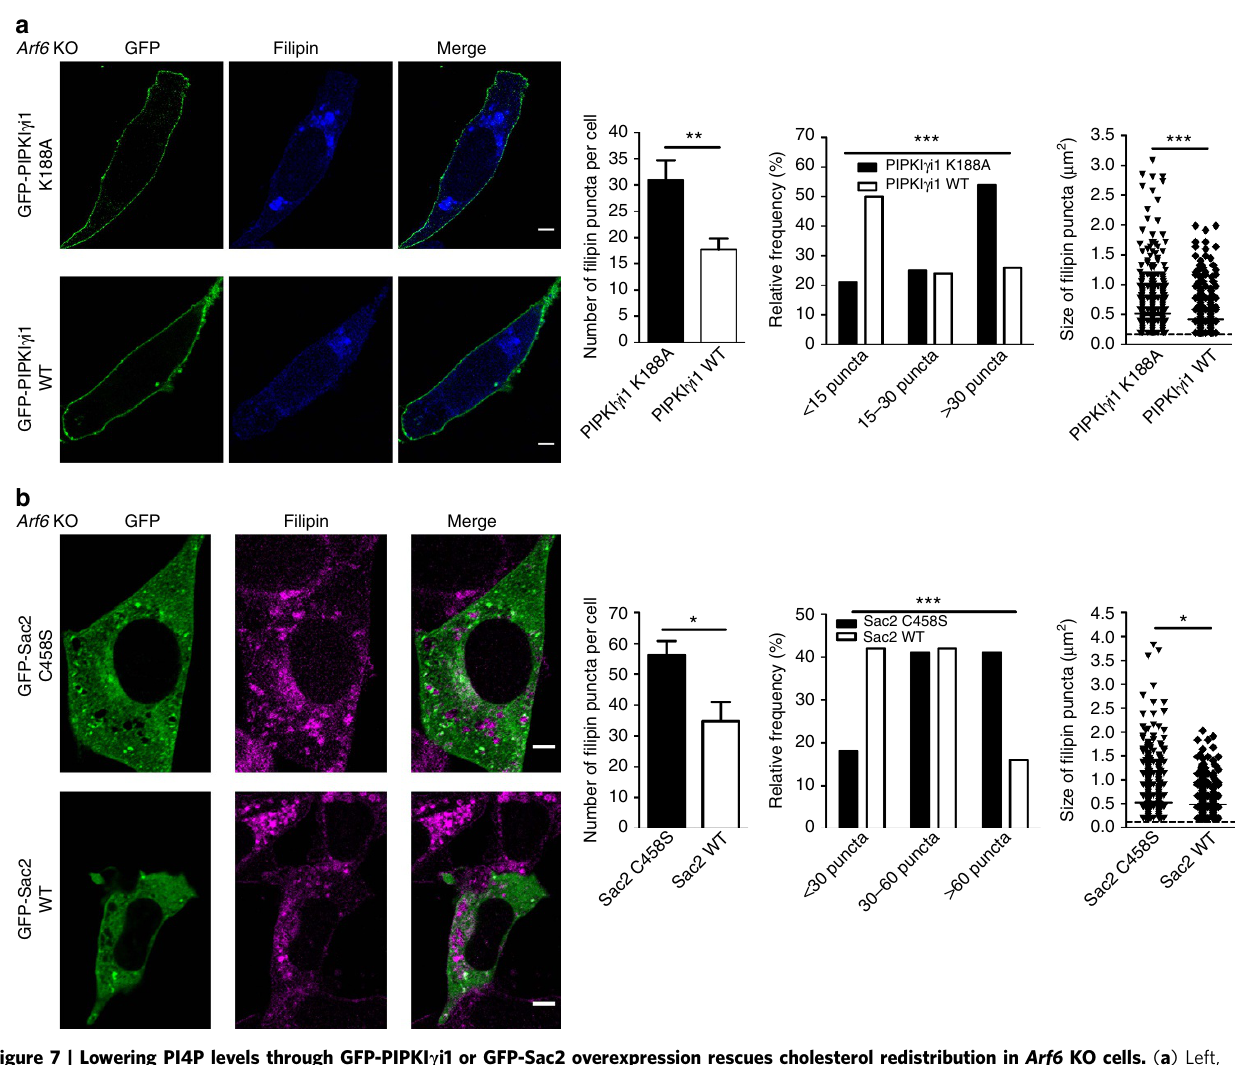
Figure 7 | Lowering PI4P levels through GFP-PIPKI c i1 or GFP-Sac2 overexpression rescues cholesterol redistribution in Arf6 KO cells. ( a ) Left, representative confocal images of Arf6 KO cells expressing the K188A mutant (top) or the wild-type (bottom) GFP-PIPKI g i1 (green) labelled with filipin (blue). Scale bar, 5 m m. Center, quantification of the absolute number and relative distribution of filipin puncta in Arf6 KO cells expressing K188A GFP-PIPKI g i1 (31 ± 4 puncta per cell, ± indicates s.e.m., n ¼ 24 cells, three experiments) or WT GFP-PIPKI g i1 (18 ± 2 puncta per cell, n ¼ 38 cells, five experiments). ** P o 0.01 in t -test with Welch’s correction. *** P o 0.001 in w 2 -test. Right, size of filipin puncta in Arf6 KO cells expressing K188A GFP-PIPKI g i1 (0.51 ± 0.01 m m 2 , ± indicates s.e.m., 742 puncta, 24 cells) or WT GFP-PIPKI g i1 (0.42 ± 0.01 m m 2 , 671 puncta, 38 cells). *** P o 0.001 in Mann–Whitney test. ( b ) Left, representative confocal images of Arf6 KO cells expressing the C458S mutant (top) or the wild-type (bottom) GFP-Sac2 (green) and labelled with filipin (magenta). Scale bar, 5 m m. Center, quantification of the absolute number and relative distribution of filipin puncta in Arf6 KO cells expressing C458S GFP-Sac2 (56 ± 5 puncta per cell, ± indicates s.e.m., n ¼ 27 cells, three experiments) or WT GFP-Sac2 (35 ± 6 puncta per cell, n ¼ 12 cells, three experiments). * P o 0.05 in Student’s t -test. *** P o 0.001 in w 2 -test. Right, size of filipin puncta in Arf6 KO cells expressing